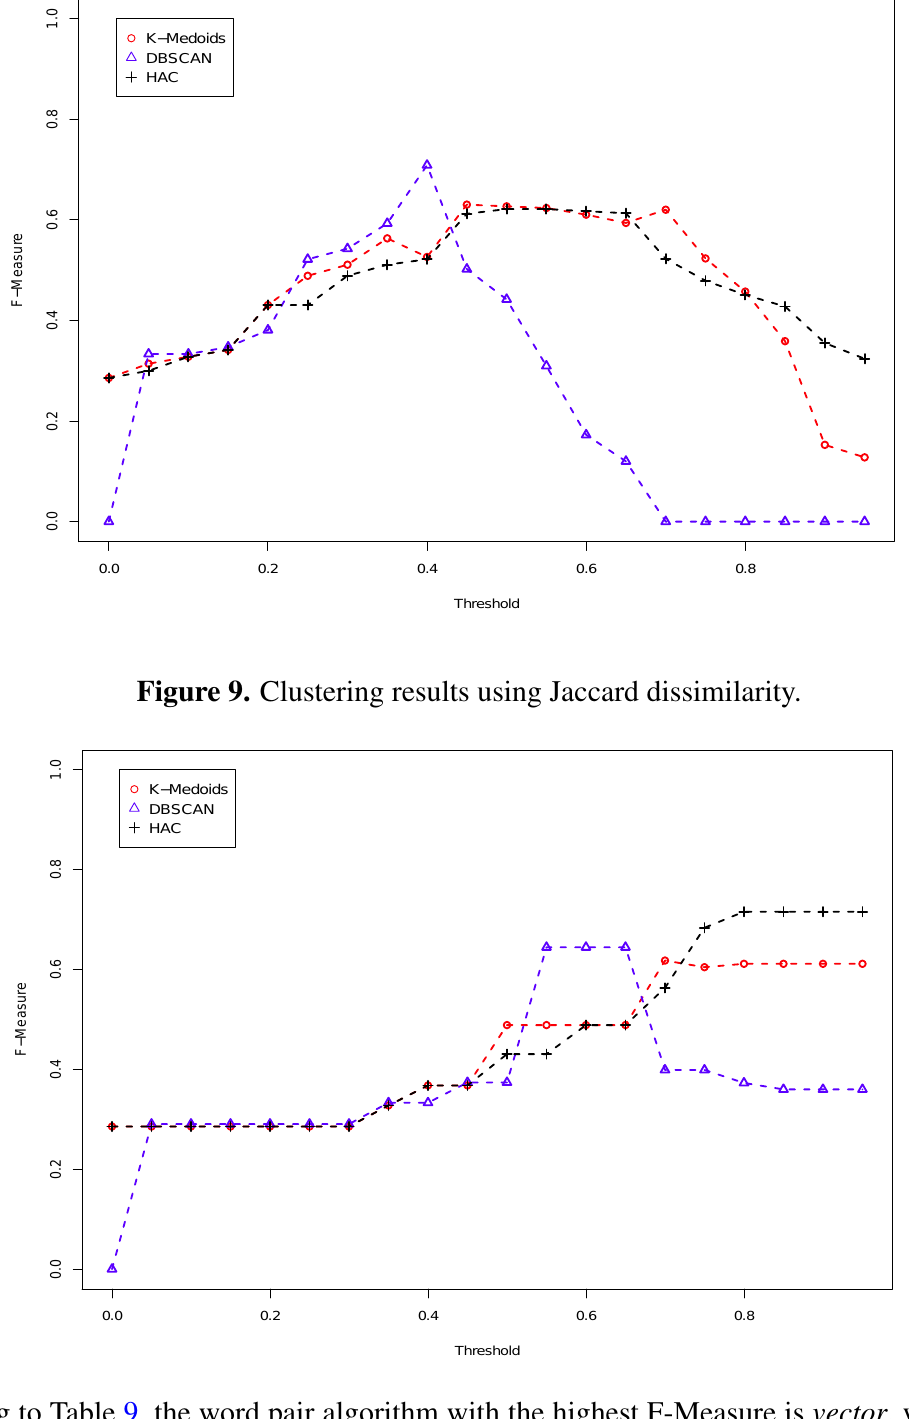
Figure 8. Clustering results using length adjusted Levenshtein dissimilarity.